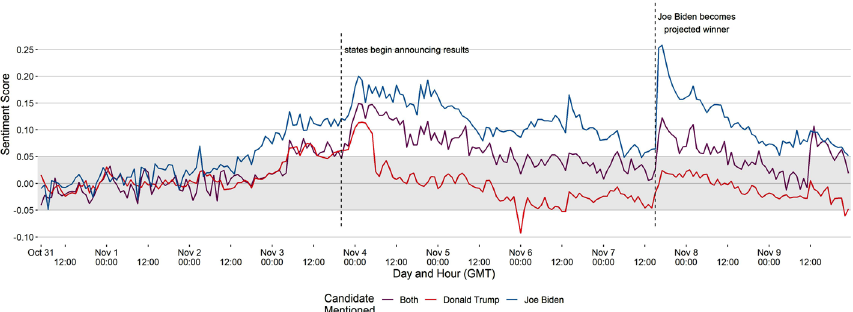
Fig. 4 Timeline of sentiment scores of tweets that mentioned presidential candidates. Average sentiment scores are computed per hour for the duration of the study days. Timezone for date time is in